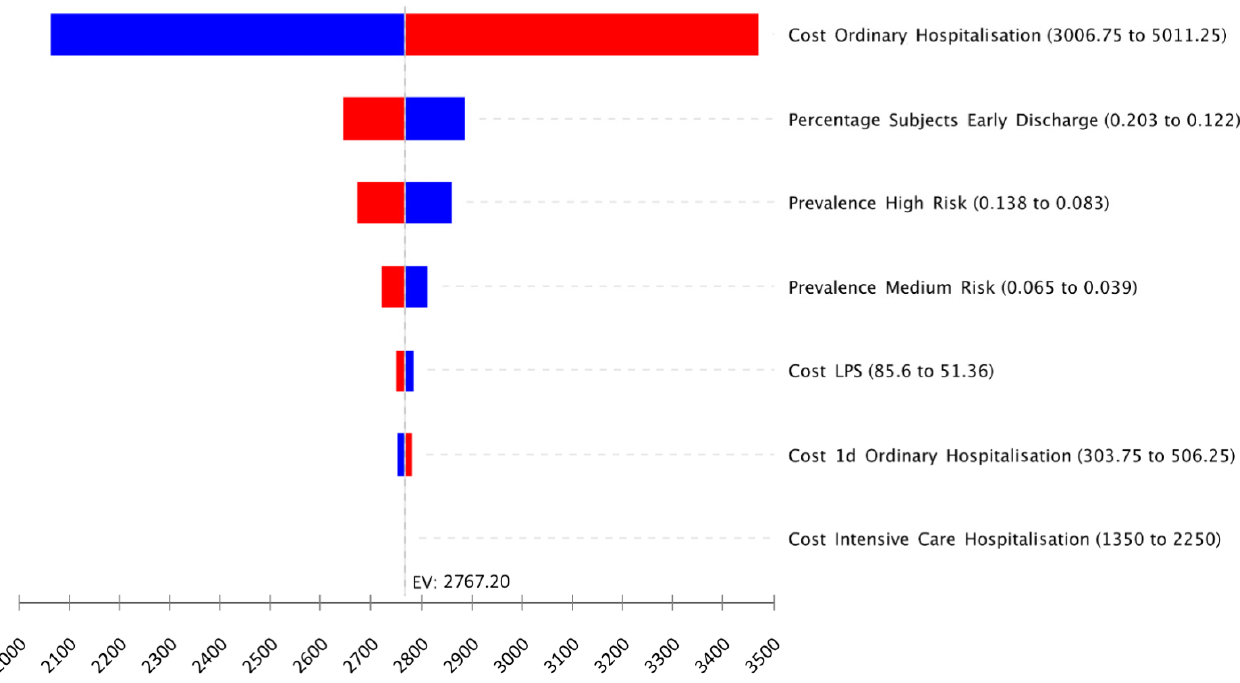
Figure 4. Tornado diagram of one-way sensitivity analyses of the differences between the two strategies. EV, expected value with baseline parameters; LPS, lung pulmonary scintigraphy. Blue bars indicate the effect of the parameter decrease.